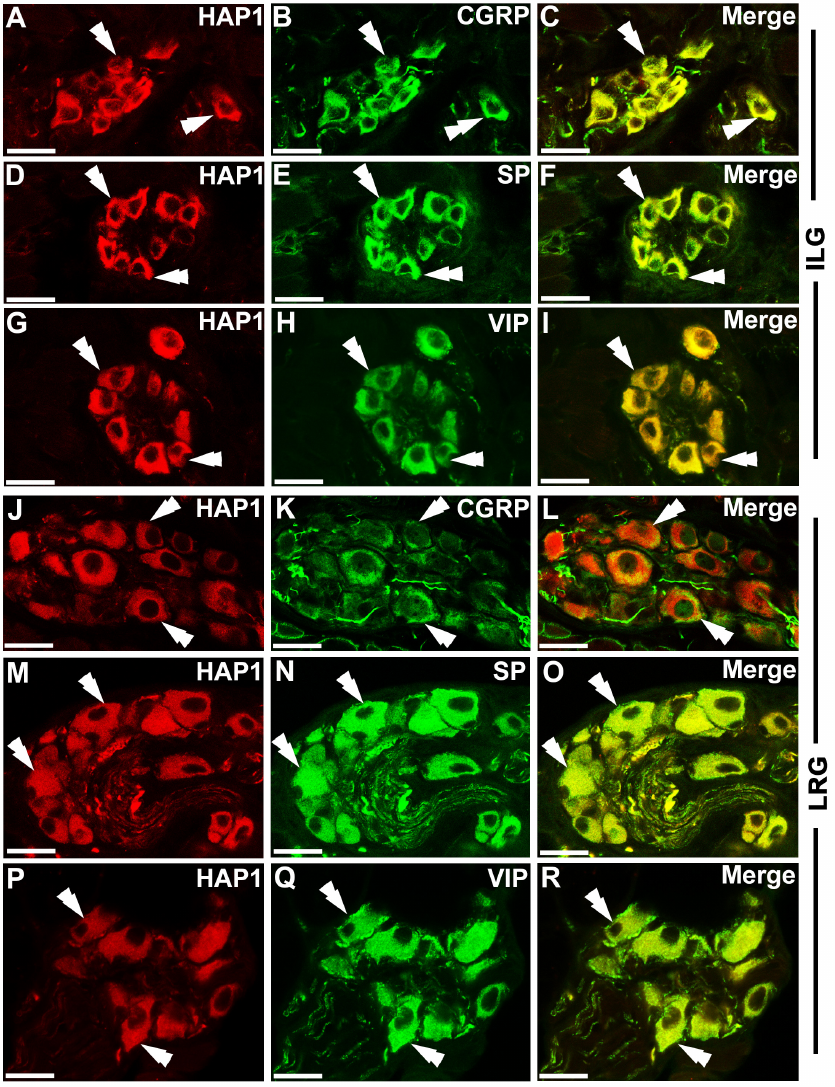
Figure 4. Double immunofluorescence histochemistry for HAP1 with CGRP, SP, or VIP. Photomi- crograph showing the coexpression of HAP1 with CGRP in ILG ( A – C ) or LRG ( J – L ); HAP1 with SP in ILG ( D – F ), or LRG ( M – O ); and HAP1 with VIP in ILG ( G – I ), or LRG ( P – R ). Cells positive for both HAP1 and CGRP, HAP1 and SP, or HAP1 and VIP are indicated by double arrowheads. ILG, intralingual ganglion; LRG, lingual root ganglion. Scale bar = 25 µm in ( A – R ).